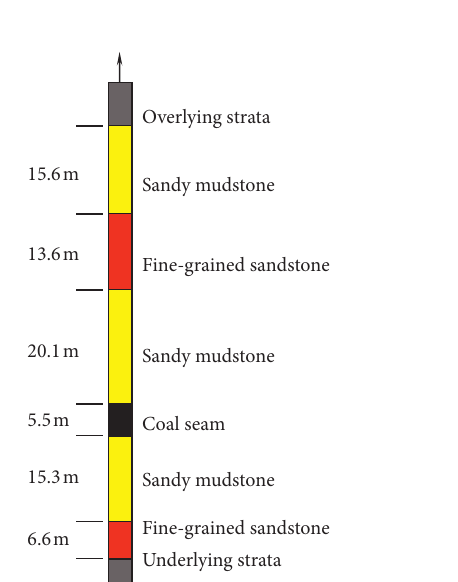
Figure 2: The location of the mine.